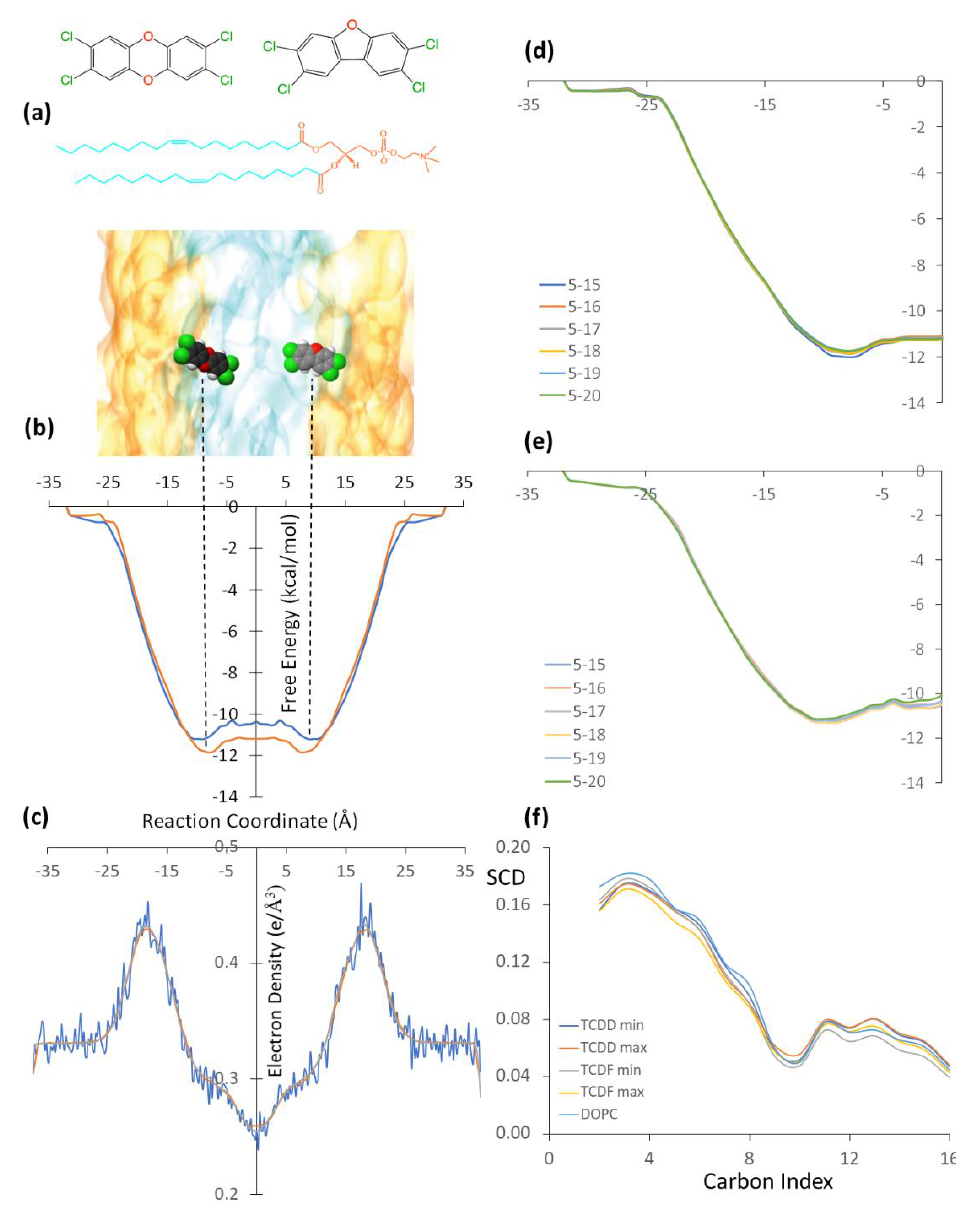
Figure 1. ( a ) Schematic representation of the TCDD (left) and TCDF (right) molecules embedded in a DOPC lipid bilayer. The polar and non-polar regions of the lipid bilayer are represented in orange and cyan, respectively. ( b ) Free energy profiles of the TCDD (red line) and TCDF (blue line) permeation processes through the lipid bilayer. The free energy minima are indicated by vertical dashed lines. ( c ) Electron density profile of the membrane along the reaction coordinate. ( d ) Free energy convergence analysis for TCDD using different simulation times per window, the time intervals are given in ns, and units of the free energies and reaction coordinates correspond to those displayed in the full free energy profile. ( e ) Free energy convergence analysis for TCDF using different simulation times per window. ( f ) Deuterium order parameter (SCD) of the acyl chains for the umbrella sampling windows corresponding to the energy minima and maxima for TCDD and TCDF and for a simulation of the membrane in absence of the TCDF and TCDD. Carbon atoms are numbered starting with the one closest to the polar head.